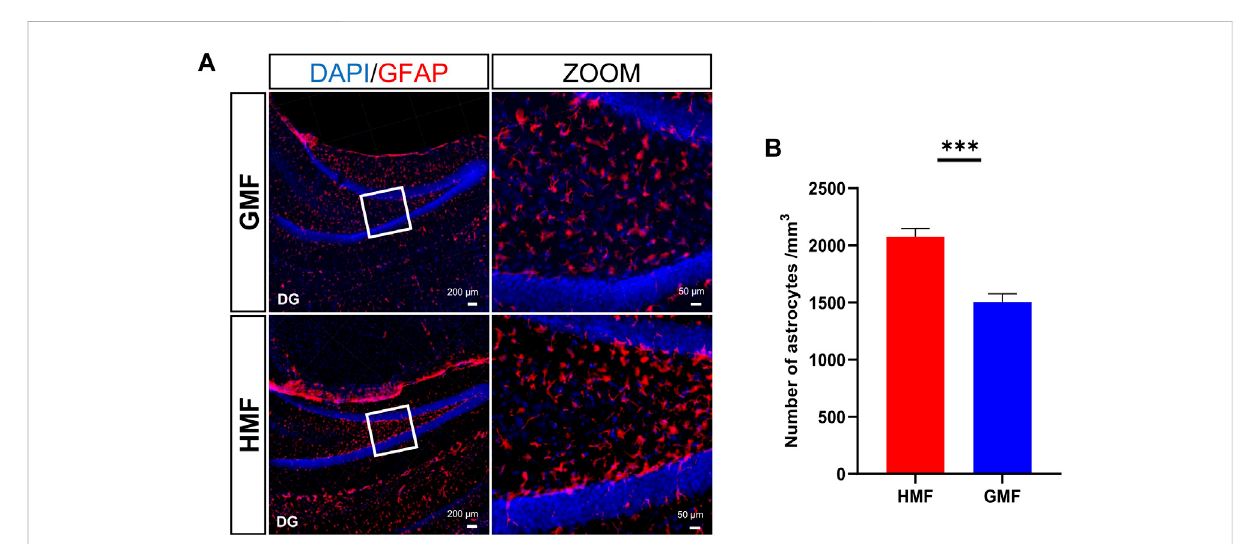
FIGURE 6 Thehypomagnetic fi eld(HMF)increasedthenumberofastrocytesintheDGofhippocampus. (A) Therepresentativeimagesofastrocytesinthe hippocampalneurogenicnicheunderdifferentmagnetic fi eldtreatments,astrocytes(GFAP-labeled,red),hippocampalcells(DAPI-labeled,blue). (B) Quantitative statistical analysis of the number of astrocytes in the DG area of hippocampus under different magnetic fi eld treatments ( p = 0.0008). There were 4 mice in each group. Data are expressed as mean ± SEM. *** p <